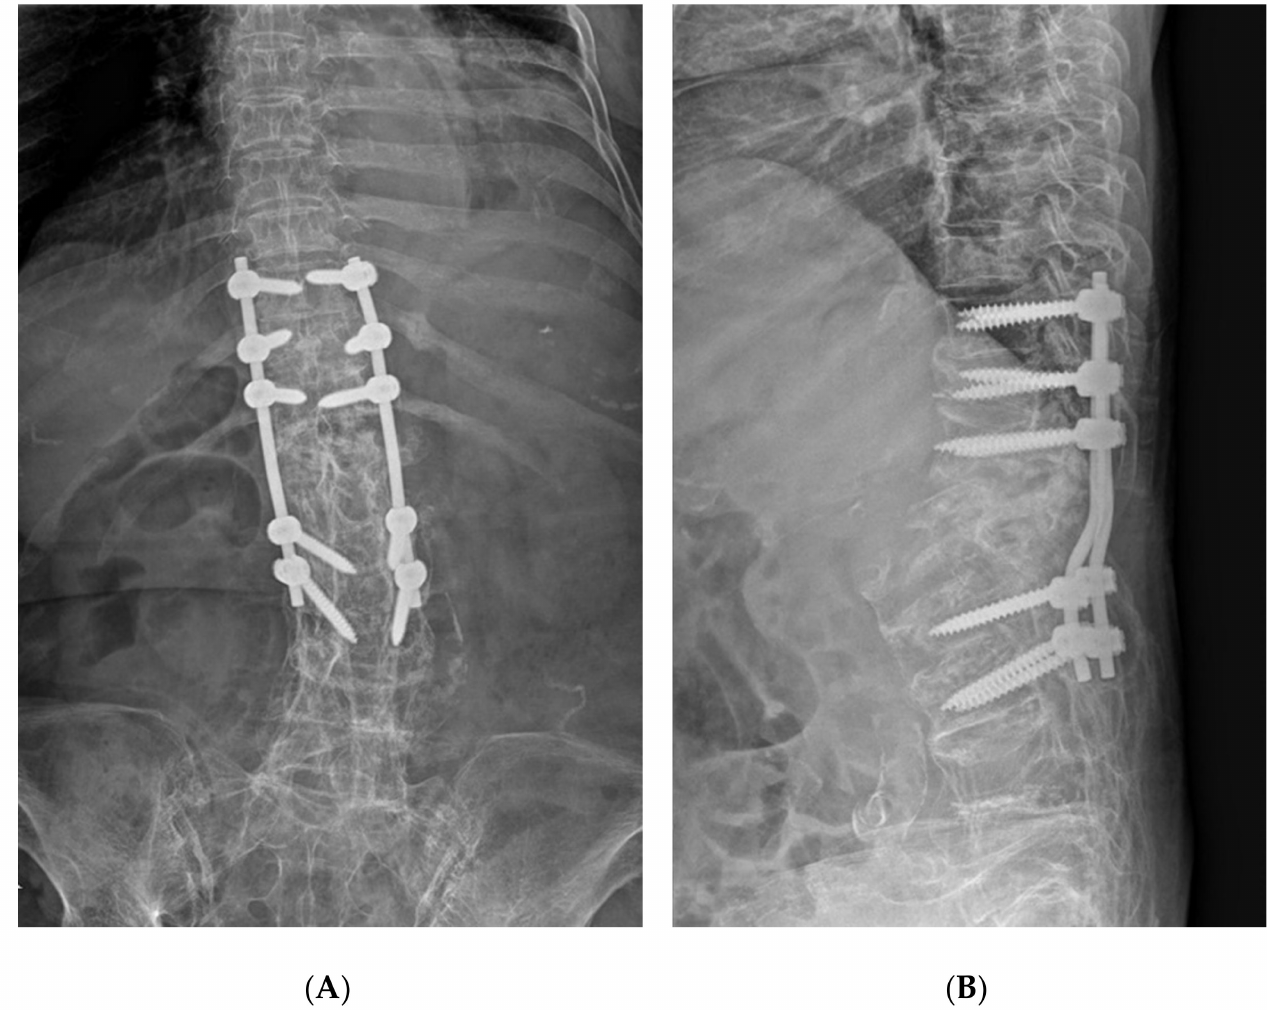
Figure 3. Postoperative plain radiograph ( A , B